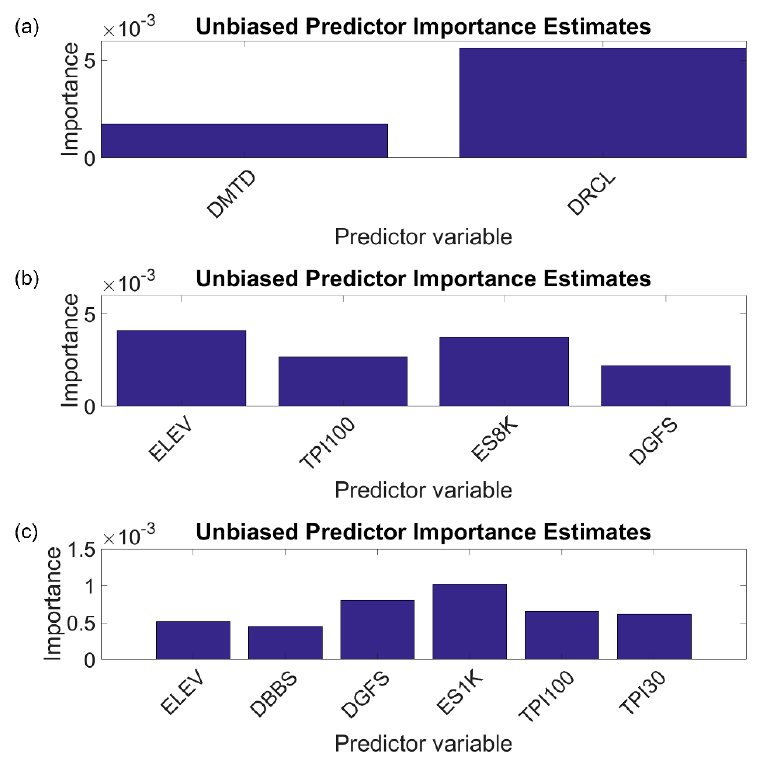
Figure A2. Unbiased predictor importance estimates by model zone for the contemporary habitat model fitting Dauphin Island, Alabama, USA. ( a ) Subtidal zone; ( b ) intertidal zone; and ( c ) supratidal / upland zone. DBBS: Distance from back-barrier shoreline; DGFS: Distance from ocean-facing shoreline; DMTD: Distance from Mobile-Tensaw River Delta; DRCL: Direction from center; Elevation; ELEV: Elevation; ES1K: Elevation to the south (1 km); ES8K: Elevation to the south (8 km); TPI30: Topographic position index (30 m); TPI100: Topographic position index (100 m). Table A6. The type, condition, and order for user-defined rules applied to model results via post- processing by habitat class for the habitat model for Dauphin Island, Alabama, USA.